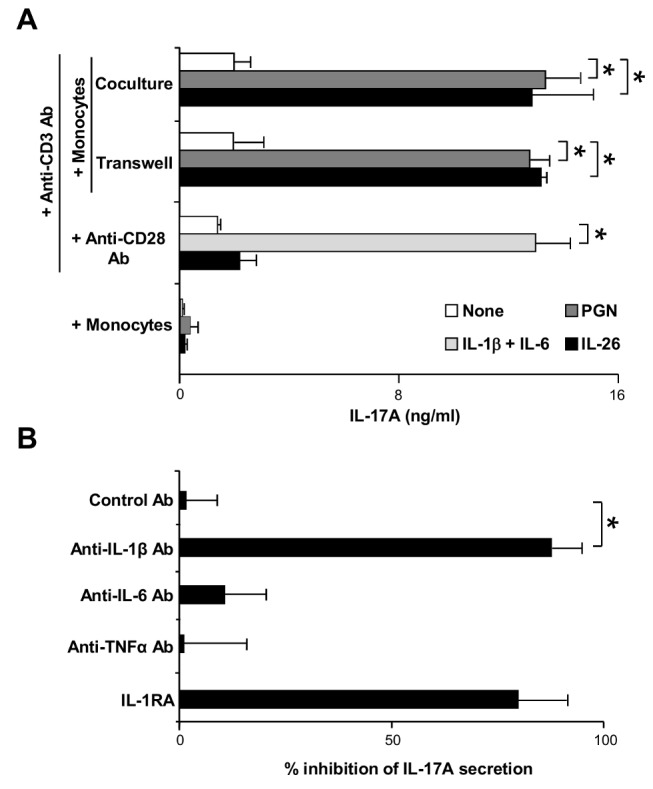
IL-26 promotes IL-17A production by memory CD4+ T cells through IL-1-beta secretion by monocytes.(A) Memory CD4+ T cells were stimulated with an anti-CD3 Ab, with or without 50 ng/ml IL-26, in the presence of (i) monocytes, (ii) monocytes cultured in separate chambers (Transwell inserts), or (iii) an anti-CD28 Ab. Memory CD4+ T cells were also cultured with monocytes in the absence of anti-CD3 or anti-CD28 Ab. PGN (5 µg/ml) or 10 ng/ml IL-1-beta plus 50 ng/ml IL-6 were used as positive controls. After 1 wk, IL-17A was quantified by ELISA in the supernatants. Results are expressed in ng/ml (mean ± SD, n = 4). (B) Memory CD4+ T cells were stimulated by an anti-CD3 Ab plus monocytes, with or without 50 ng/ml IL-26, in the presence or absence of 10 µg/ml neutralizing anti-IL-1-beta, anti-IL-6, anti-TNF-alpha, isotype control Abs, or 1 µg/ml soluble IL-1RA. IL-17A was quantified after 1 wk. Results are expressed as percentage of inhibition of IL-17A secretion (mean ± SD, n = 4). (A and B) *p<0.05 (Wilcoxon matched-pairs signed-ranks test).